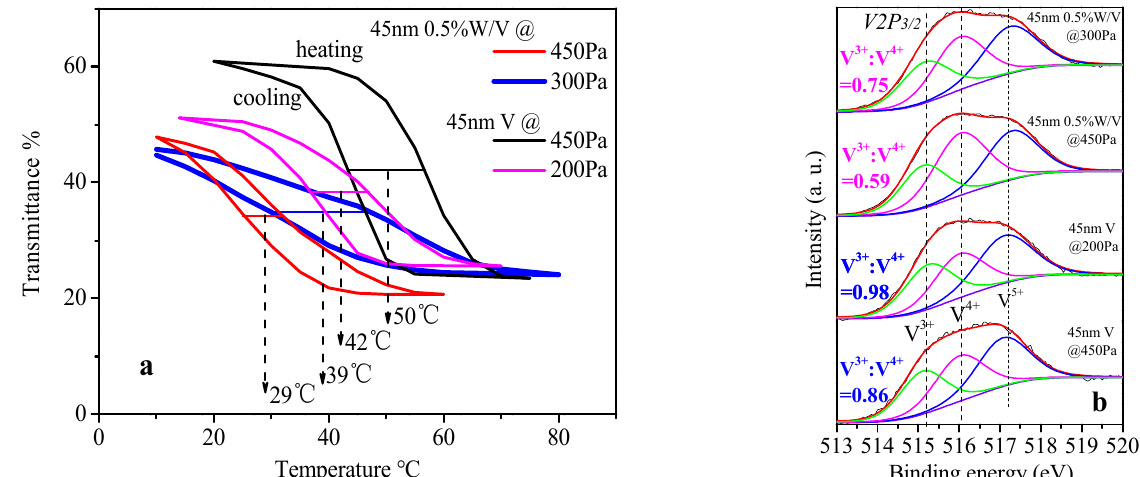
Figure 10. ( a ) Effect of lowering the annealing pressure on the thermal hysteresis loop of the prepared VO 2 films and W/VO 2 films (from 450 Pa to 200 Pa for 45 nm V; from 450 Pa to 300 Pa for 45 nm 0.5%W/V; all at 400 °C for 1 h); ( b ) XPS spectra of V 3+ , V 4+ of the corresponding VO 2 films and W/VO 2 films.